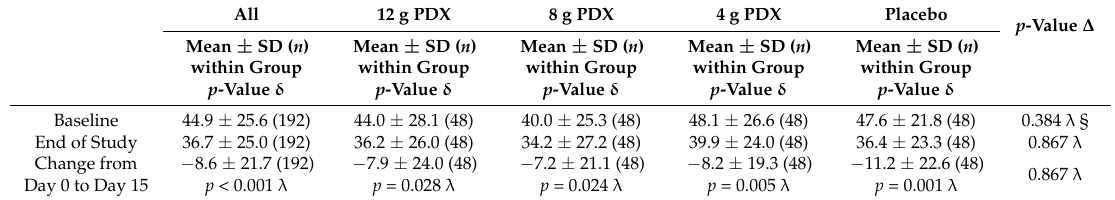
Table 5. Average bowel function index questionnaire results at baseline (Day 0) and end of study (Day 15) for participants in the intention-to-treat population ( n = 192).